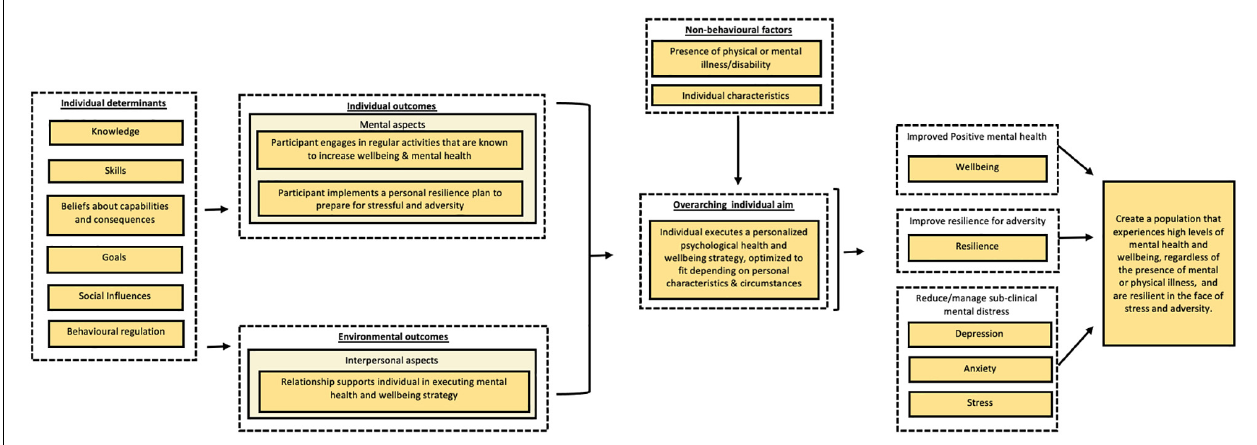
FIGURE 2 | Simplified overview of the needs analysis for the Be Well Plan. The specific explanatory role of variables (e.g., mediating or moderating) is not taken into account in this figure. The model merely serves to outline the variability of behaviours and determinants that influence wellbeing and resilience using the PRECEDE-PROCEED model outline. Determinants are based on the Theoretical Domains Framework